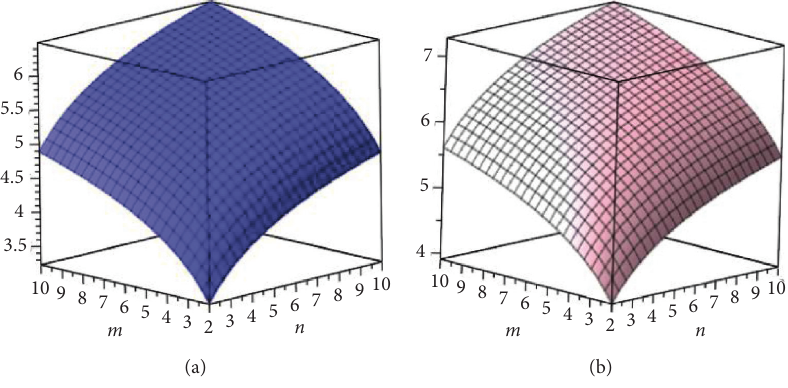
Figure 12: (a) The ABC